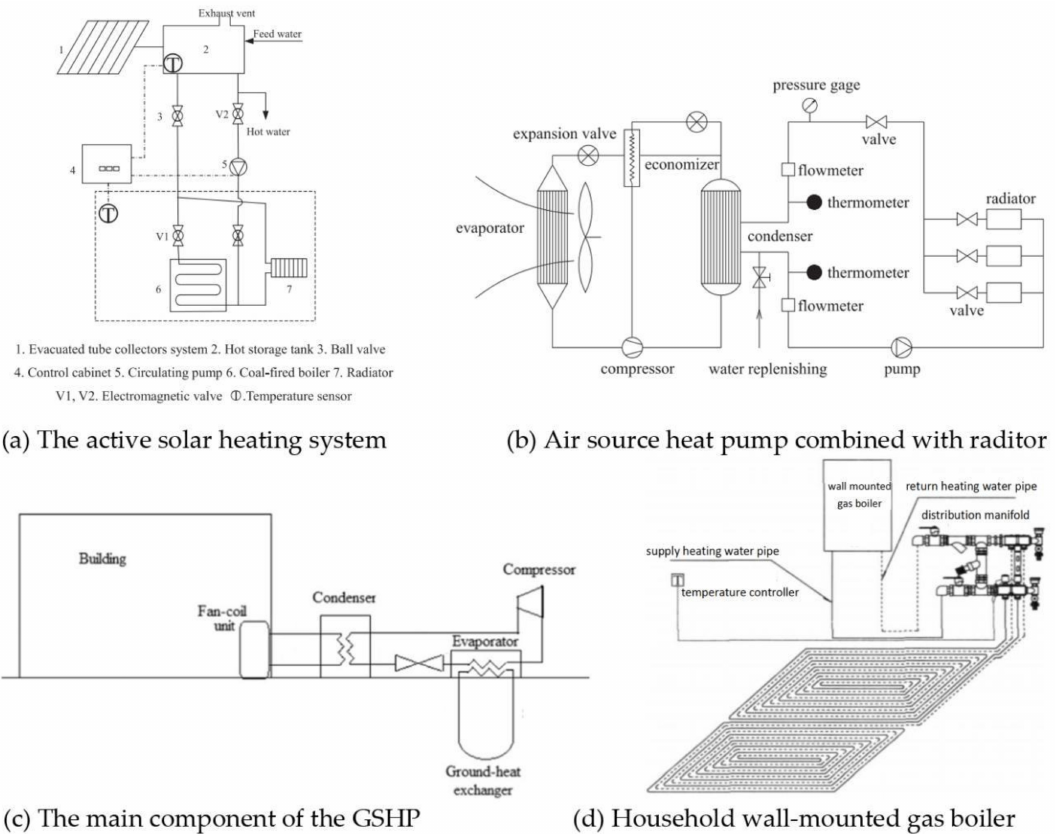
Figure 2. Schematic diagrams of new rural heating